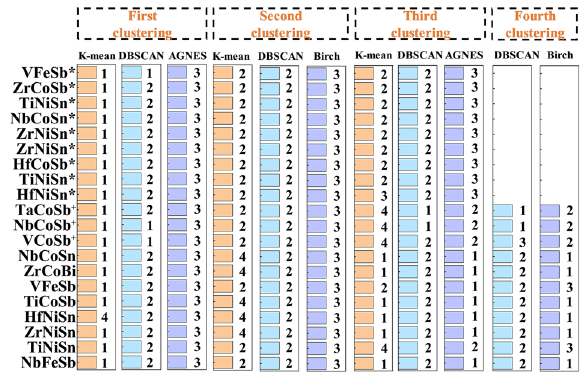
Fig. 3 The TE cluster indexes. The unsupervised cluster indexes for the labeled reported thermoelectric materials in different